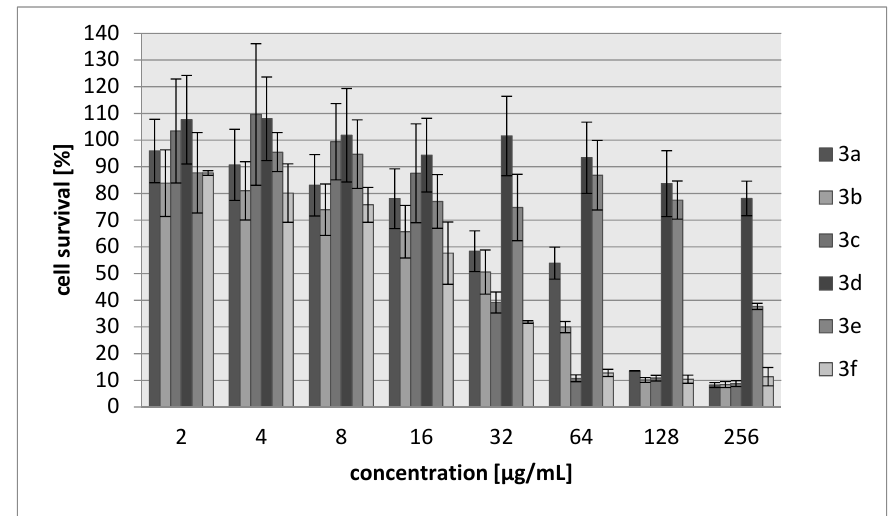
Figure 3. Concentration-dependent cytotoxic activity of 3a , 3b , 3c , 3d , 3e , 3f for L929 cell line.